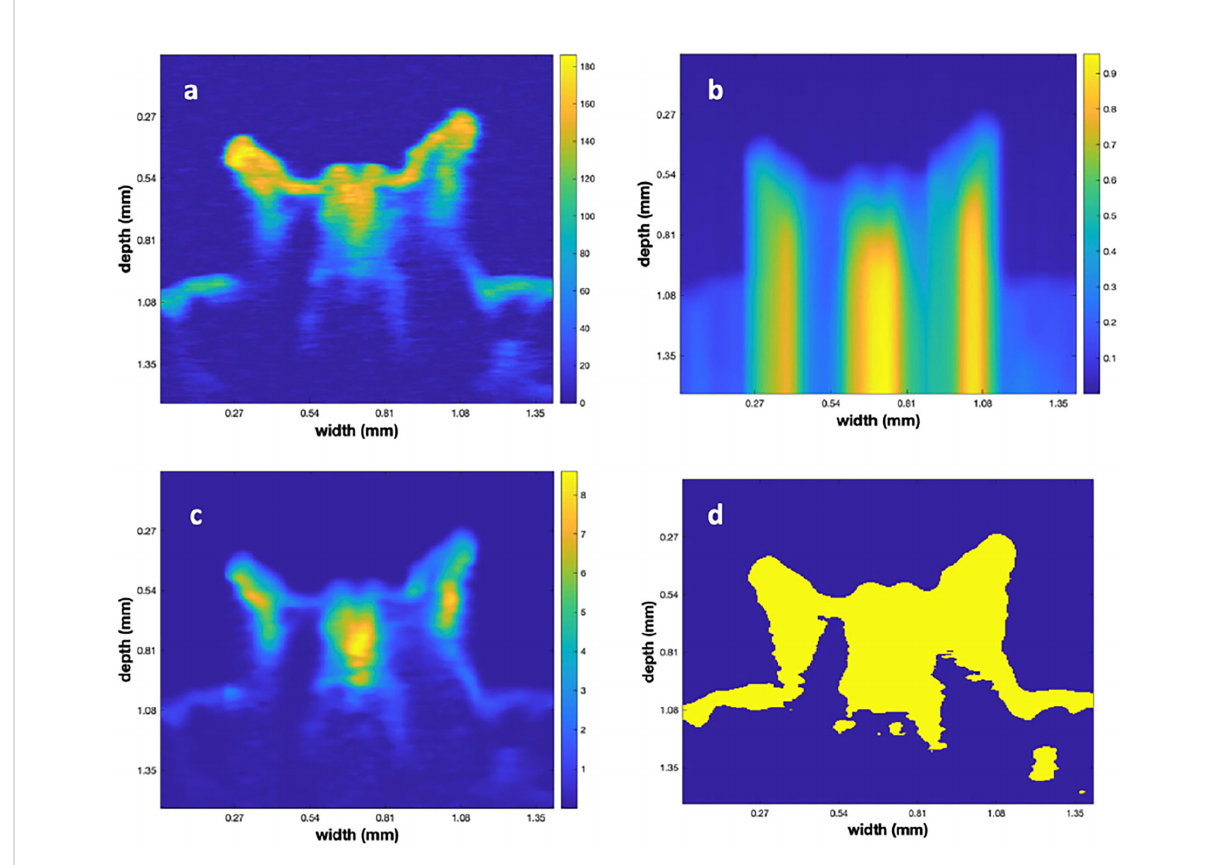
( x , y , z ) function, computed using formula (2). Figure 4C